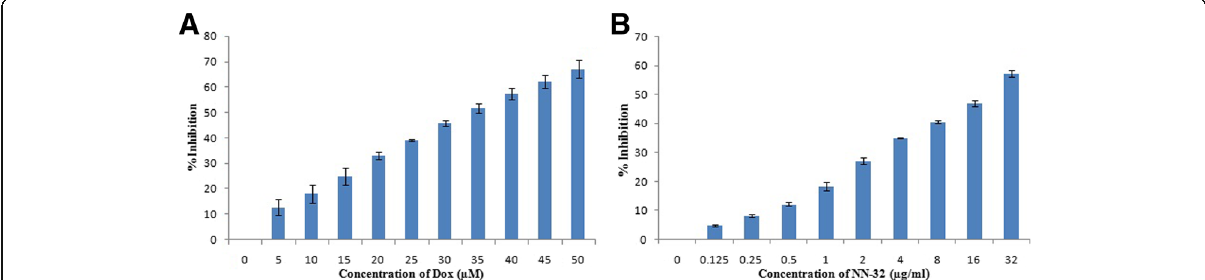
Fig. 5 Inhibition of MCF-10A cells after 48 h of treatment with ( a ) Doxorubicin and ( b ) NN-32 toxin. Values are expressed as mean ± Std. Dev ( n =